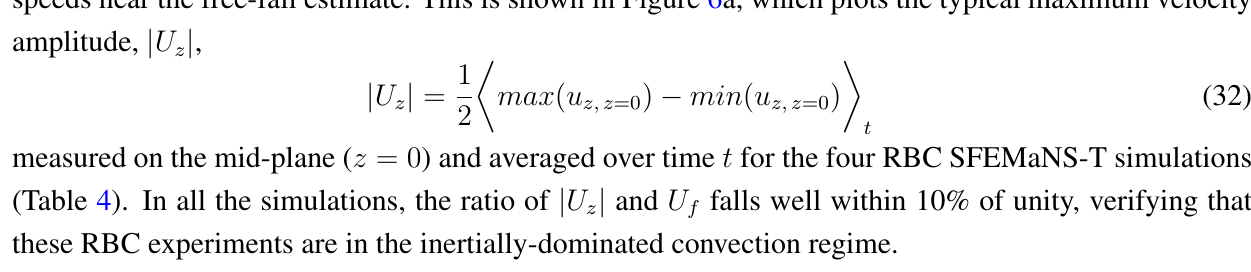
Figure 5. ( a ) Non-dimensional temperature time series, Θ( t ) , acquired on thermistors T and T in the Γ (cid:39) 4 , Ra = 1 . 02 × 10 5 RBC 1 3 5 time series measured on the point probes P ( b ) Time-averaged, non-dimensional temperature on each thermistor ( i.e. , (cid:104) Θ( T th i thermistor), normalized by value for the corresponding numerical point-probe ( (cid:104) Θ( P